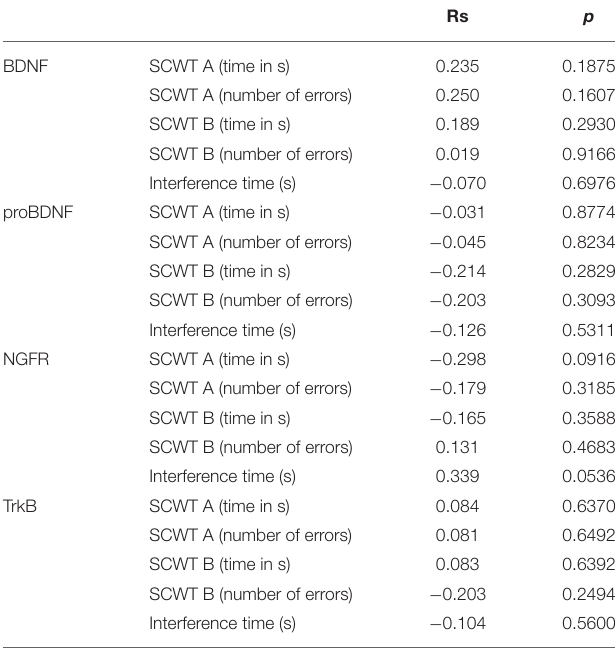
TABLE 5 | The table shows correlations between the Stroop test results (SCWT A—version A, monochrome and SCWT B—version B, color) and the concentrations of the studied neurotrophic factors after